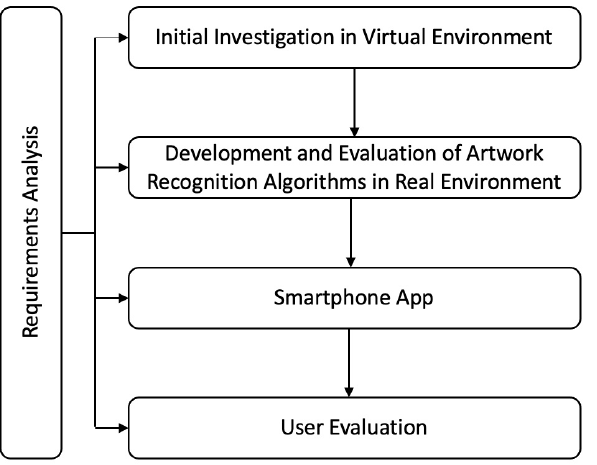
Figure 1. The systematic approach we followed for the robust artwork